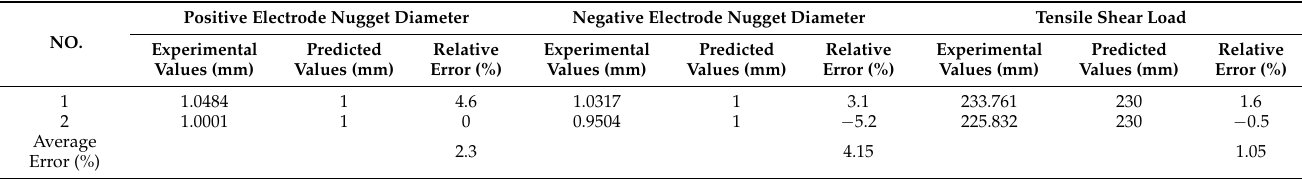
Table 9. Method II verification of relative